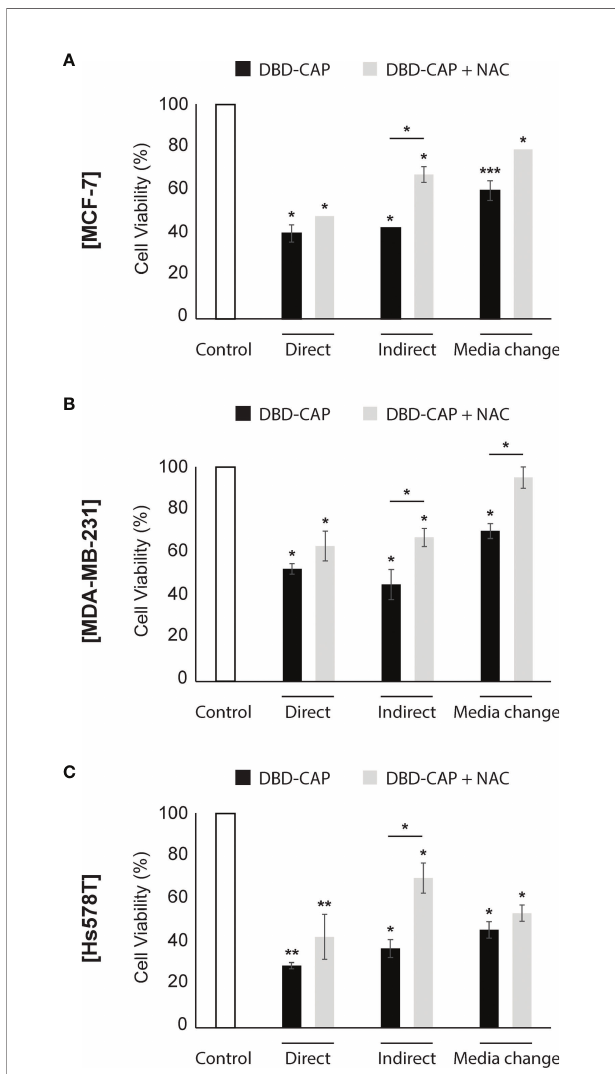
FIGURE 8 | ROS scavenger NAC partly inhibits DBD-CAP-mediated effects on breast cancer cell viability. Assessment of % cell survival 24 h after treatment of (A) MCF-7, (B) MDA-MB-231, (C) Hs578T with mild (0.5 kHz/ 27.6 kV) DBD-CAP (direct, indirect, media change) for 4 min in the absence or presence of NAC (pre-treatment with 5 mM NAC-DMEM for 2 h). The values represent the mean ± SD of 3 (at least) independent experiments. Asterisks illustrate signi fi cant differences of the different treatment conditions compared to untreated (control) cells as well as between DBD-CAP and DBD-CAP + NAC (* p < 0.05, ** p < 0.01, *** p <